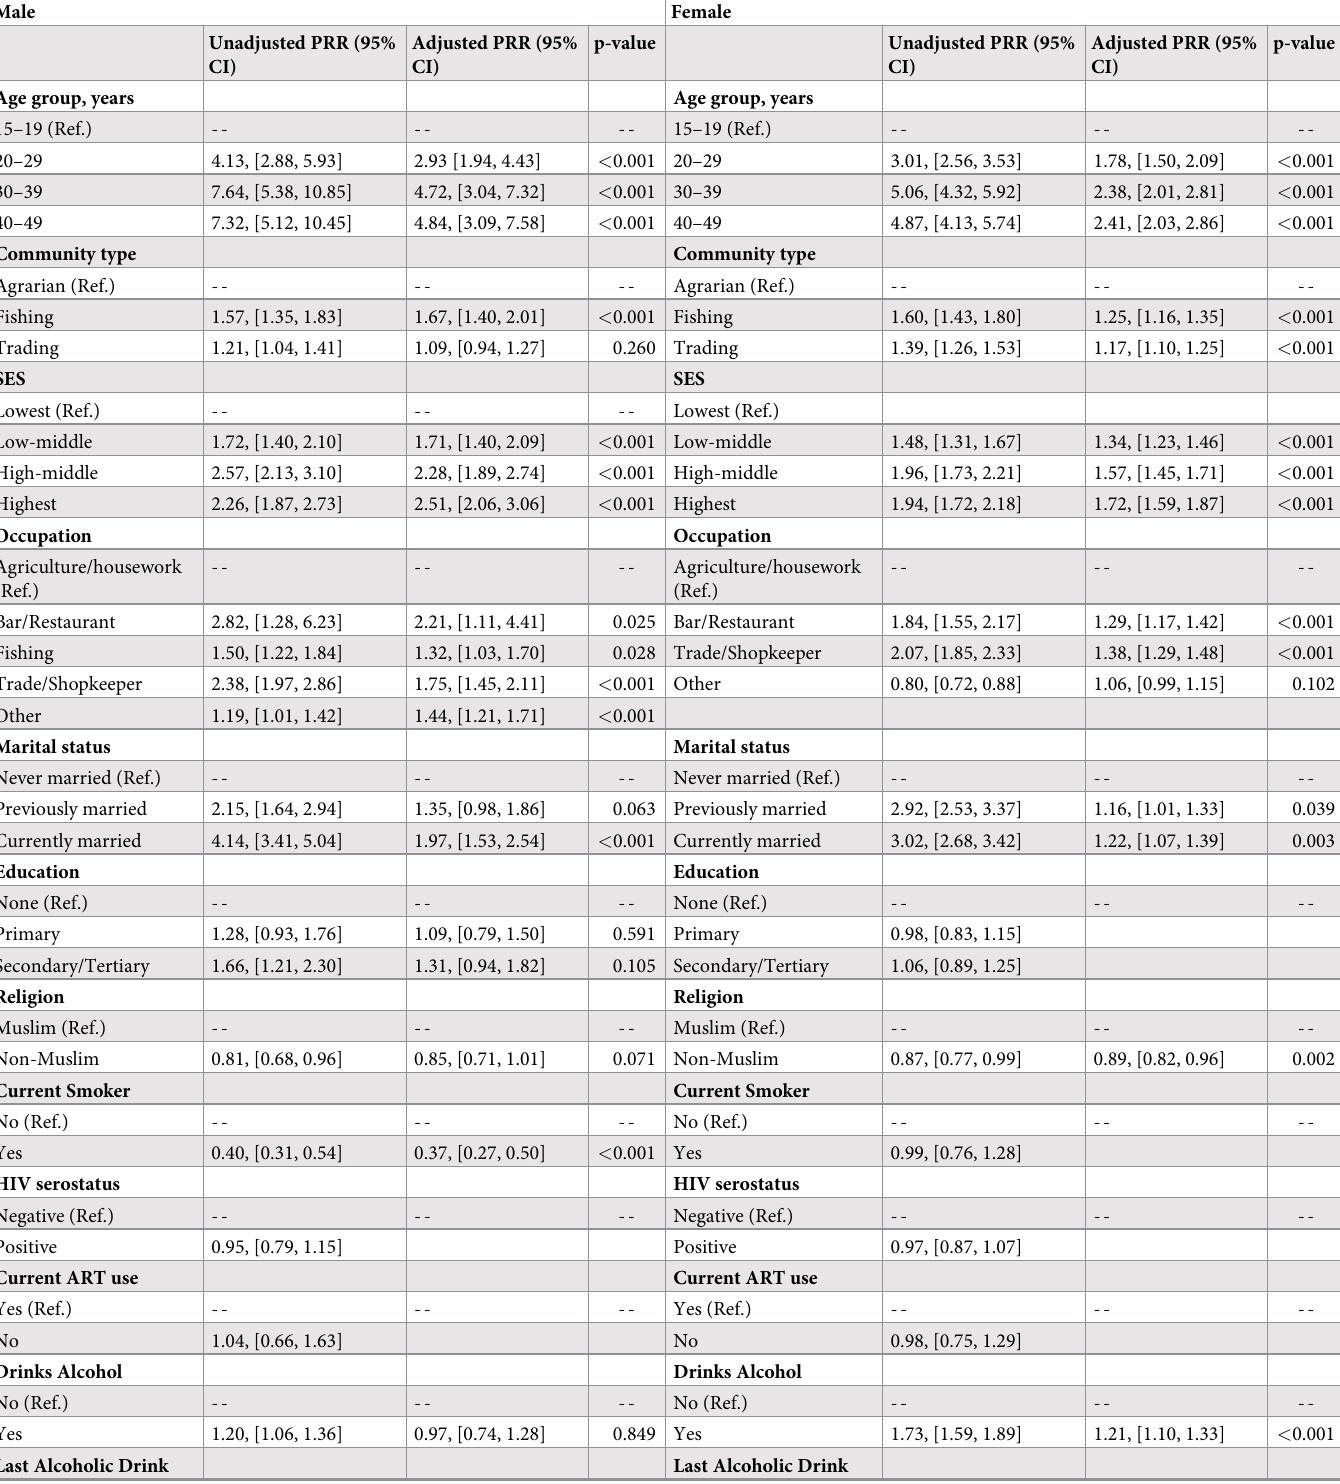
Table 5. Predictors of overweight/obesity from adjusted and unadjusted multivariable analysis models for male and female